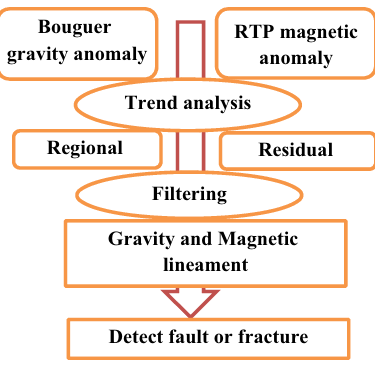
Figure 3: Work fl ow of the gravity and magnetic